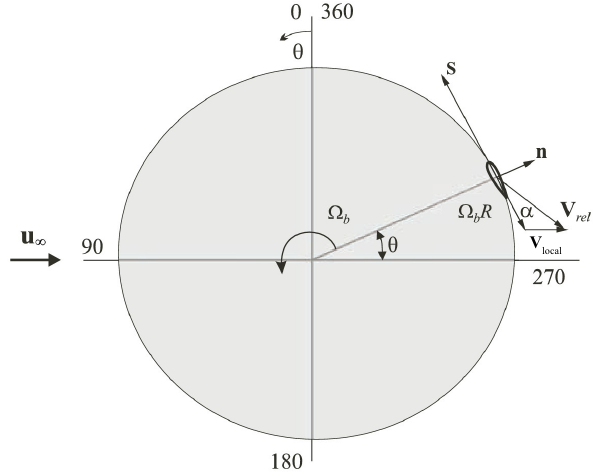
Figure 1. Schematic of a cross-section of a vertical-axis wind turbine (VAWT) blade rotating about the turbine axis [1].